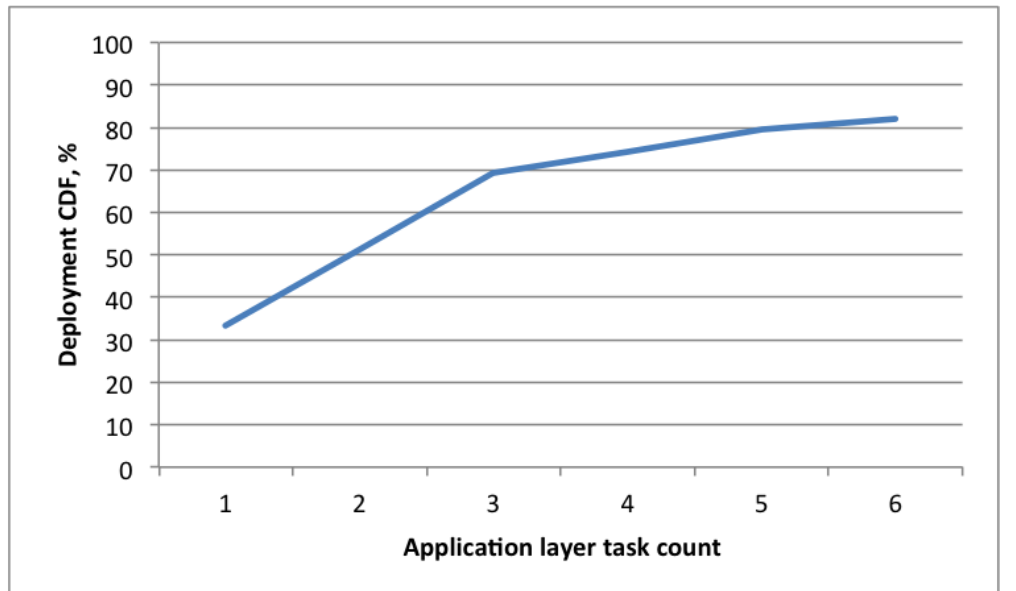
Figure 11. The number of application layer software tasks used in deployments. — Thirty-three percent of deployments use just one task; however, up to six tasks are used in more complex cases. The task count is unknown in 18% of